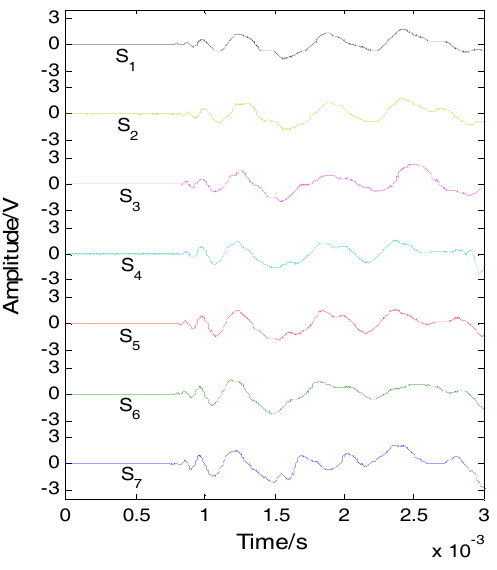
Figure 9. Impact signals of FBG array.